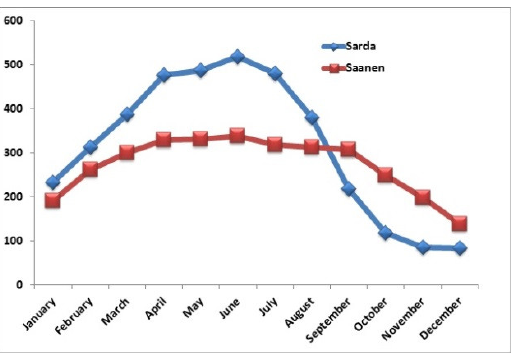
Figure 1. Number of collected milk samples per month over four years. Table 1. Descriptive statistics and means comparison of goat milk parameters collected for four years. Sarda ( n =